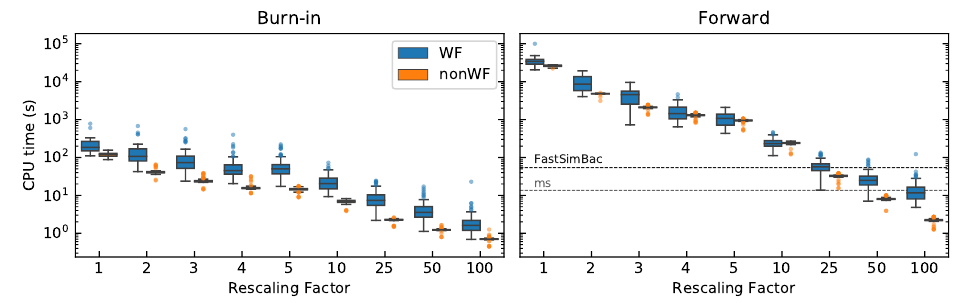
Figure S2 – Computing time as in Figure 1, but split between the burn-in and forward simulation components of the total simulation time.